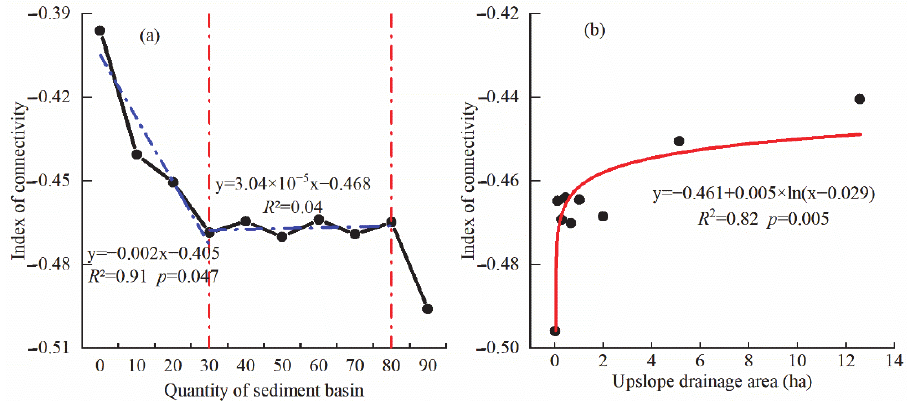
Figure 7. Changes in sediment connectivity with number of sediment basins ( a ) and road segments’ upslope drainage areas ( b ).